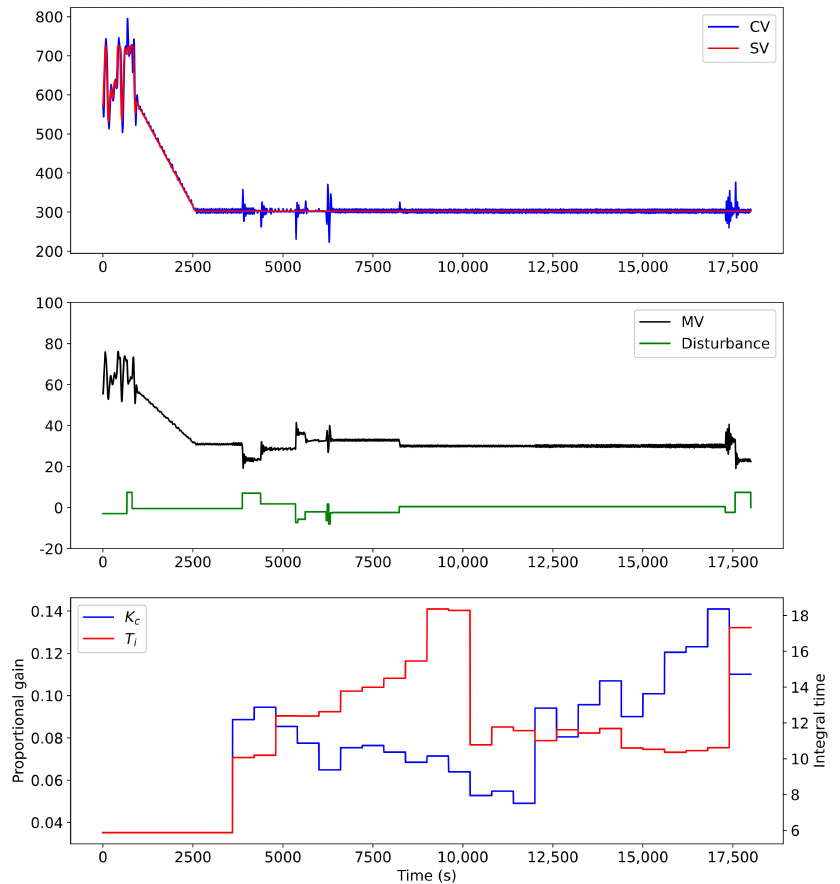
Figure 4. Improved performance obtained using the new reward function. Training was repeated using five different random number generator seeds. The minimum, maximum, and mean reward obtained during training is shown in Figure 5. The dark line represents the mean reward obtained at each step of the training, while the shaded area shows the minimum and maximum rewards at that step. The rewards obtained after approximately 750,000 training steps are sufficiently similar between training runs to conclude that the training progress does not appear to be affected by the random seed.